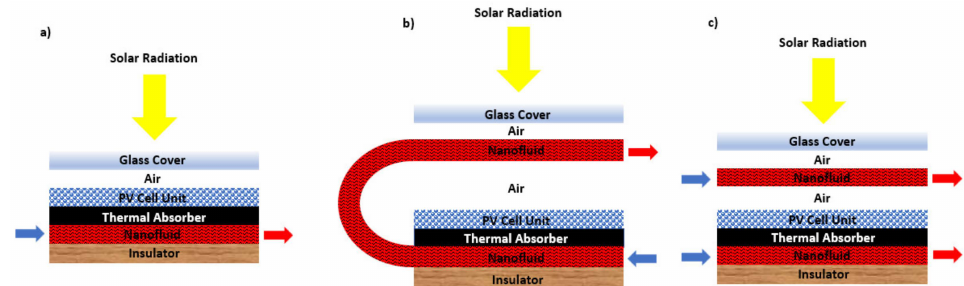
Figure 13. Configurations of typical PV/T systems with nanofluids: ( a ) as a coolant; ( b ) as a coolant and spectral filter with double-pass channel; ( c ) as a coolant and spectral filter with separate